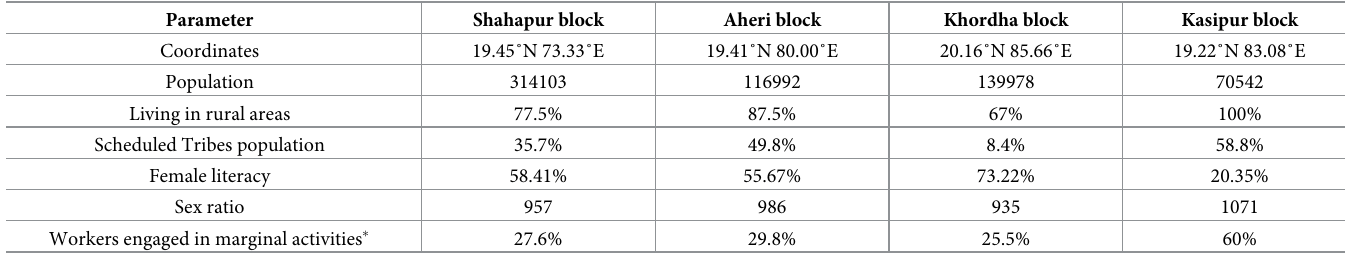
Table 1. Demographic details of the study areas in Maharashtra and